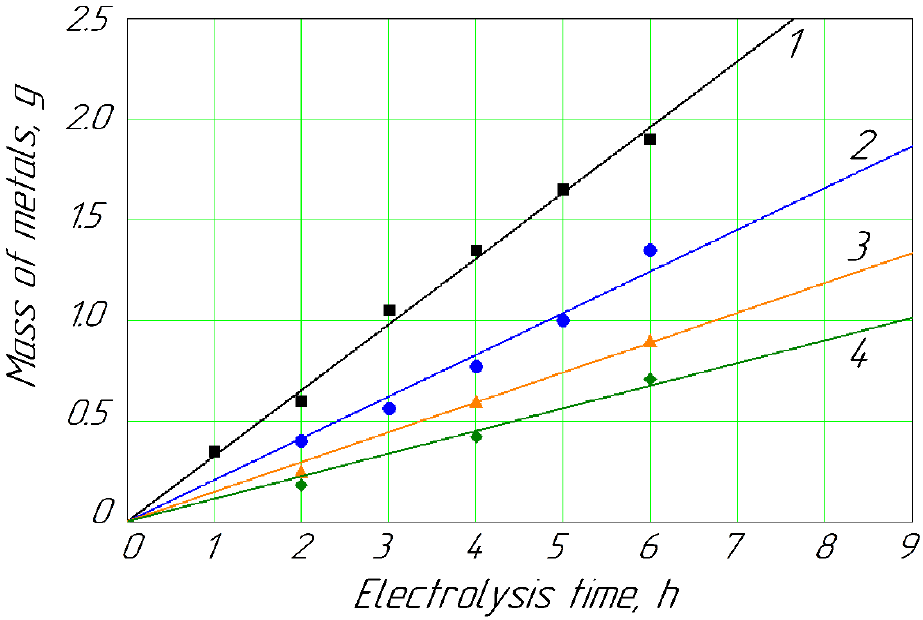
Figure 5. Deposition of metals on the cathode vs. hydrodynamic mode for concentration of Cd 2+ and Zn 2+ ions of 0.089 mol/L: 1, Cd ( Re = 2975); 2, Cd ( Re = 392, without mixing); 3, Zn ( Re = 2975); 4, Zn ( Re = 392, without mixing). Table 2. Reaction rate constants for Zn deposition on the cathode.